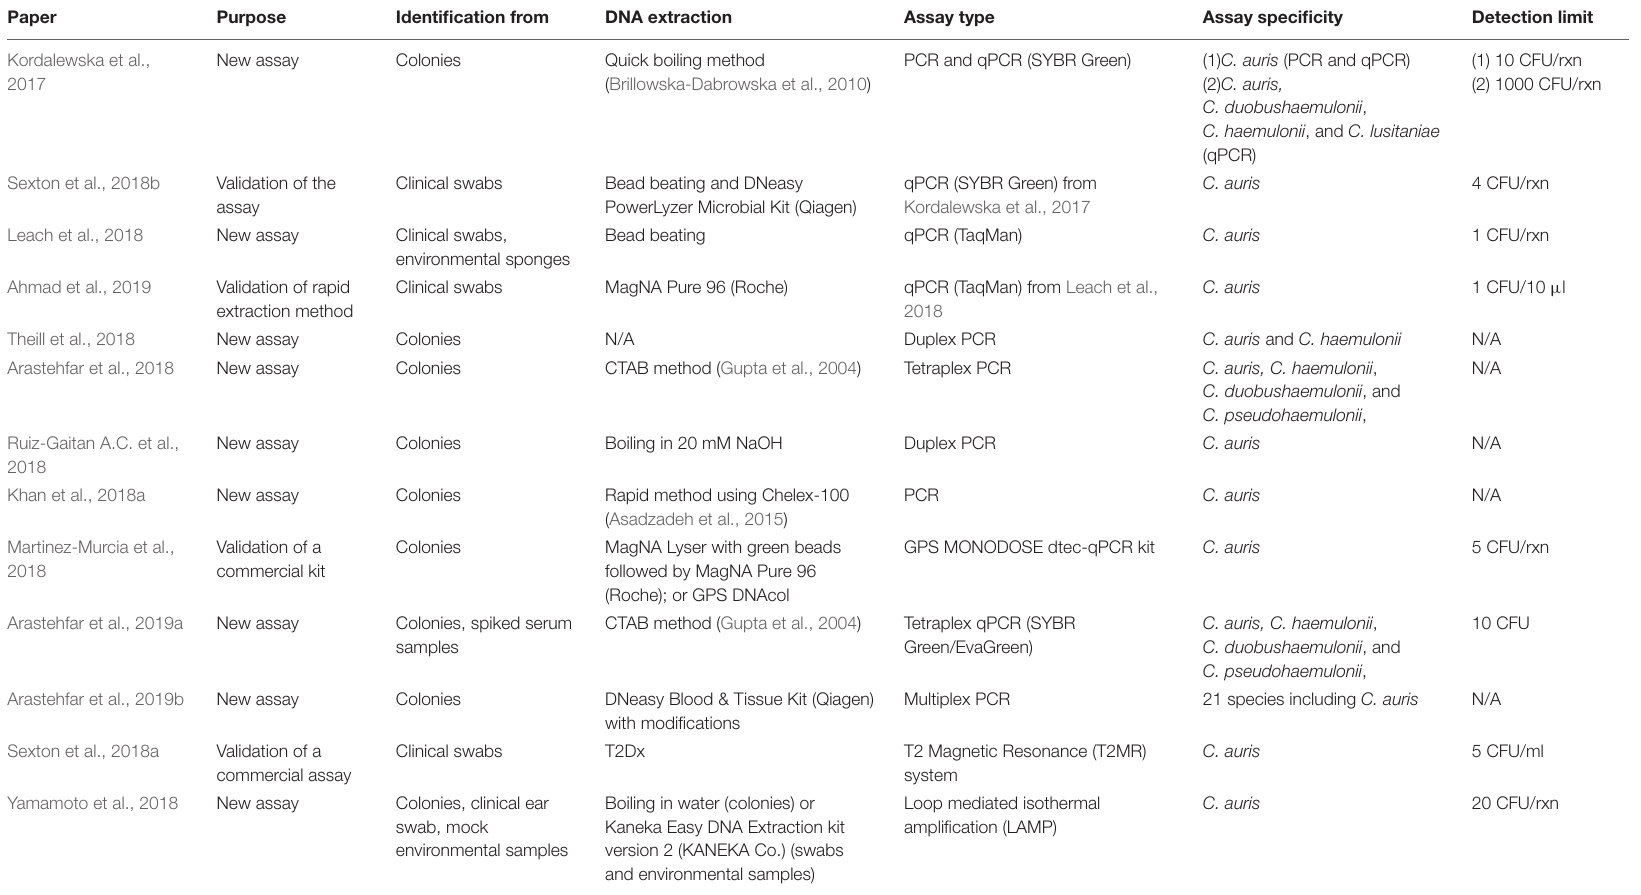
N/A, information not available. rxn,